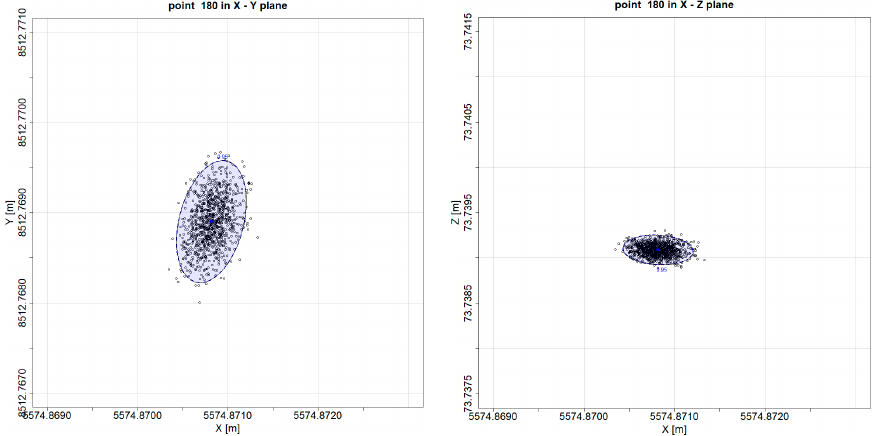
Figure 8. Point clouds of coordinate variations for stations 11, 31 and 180. Left: in X-Y plane. Right: in X-Z plane. The elliptical contour lines refer to a confidence level of 95%.